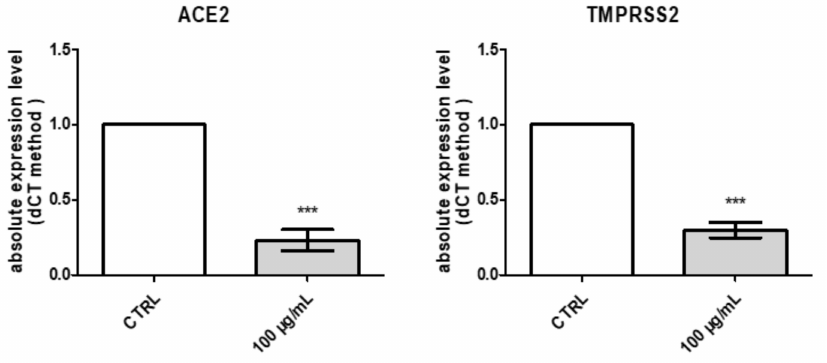
Figure 11. Inhibitory effects induced by Prunus mahaleb L. water extract (100–1000 µ g/mL) on ACE2 and TMPRSS2 gene expression in H1299 lung adenocarcinoma cells. *** p < 0.01 vs. respective CTR group.